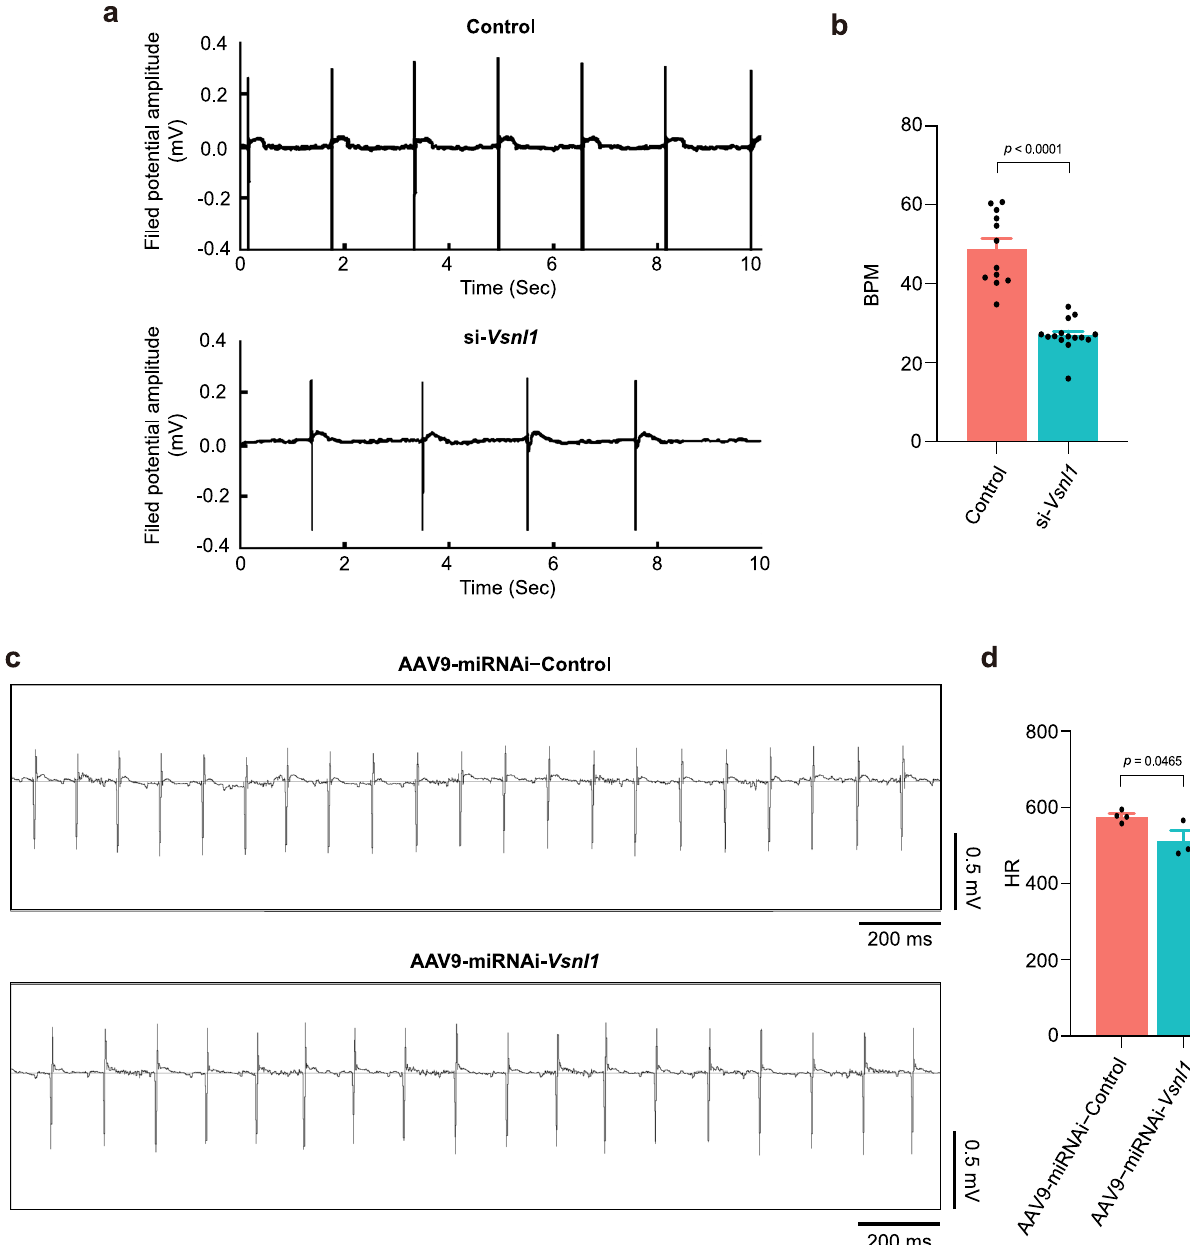
Fig. 4 The core cell cluster marker Vsnl1 governs the pacing activity. a , b Vsnl1 de fi ciency reduced the beating rate of human induced pluripotent stem cell-derived cardiomyocytes (hiPSC-CMs). a Representative fi eld potential traces in hiPSC-CMs transfected with nonsense siRNA (Control) or Vsnl1 targeting (si- Vsnl1 ) siRNA. b Statistic data of beating rates. Control: n = 12 independent examinations over three independent experiments; si- Vsnl1 : n = 15 independent examinations over three independent experiments. BPM beats per minute. c , d Vsnl1 de fi ciency reduced the heart rate of mouse. c Representative electrocardiographs (ECGs) obtained from conscious mice through telemetric recording system. d Statistic data of mouse heart rate (HR). AAV9-miRNAi-Control: n = 4 biologically independent animals; AAV9-miRNAi- Vsnl1 : n = 3 biologically independent animals. Unpaired, two-tailed Student ’ s t -test, data are represented as mean ± s.e.m., p value was labeled on the top ( b, d